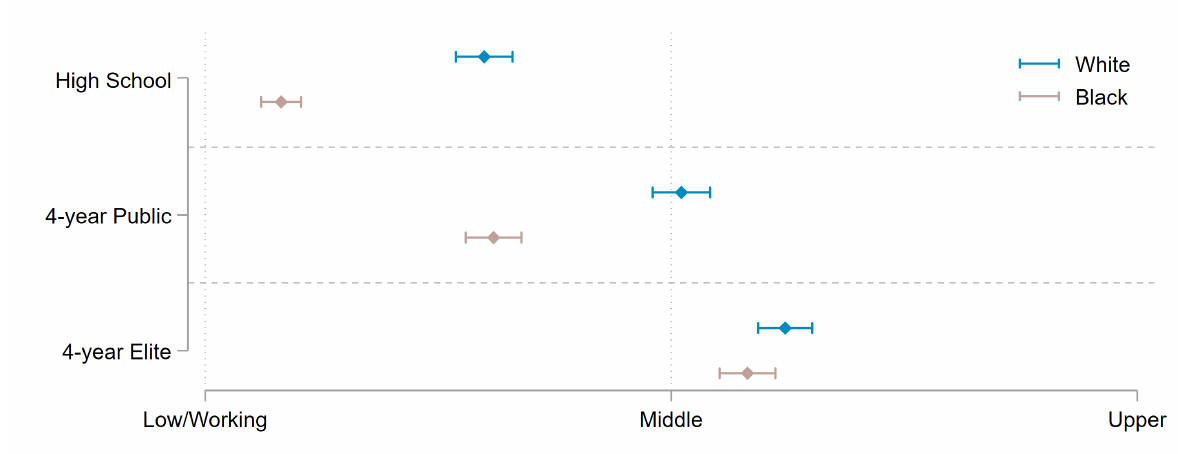
Figure 5: Social class perceptions by name-signaled race and described educational attainment. Note: Data from Study 5. This plot shows respondent perceptions of social class based on names intended to signal different racial/ethnic categories and described educational attainment. Plotted points denote predictions and bars represent 95 percent confidence